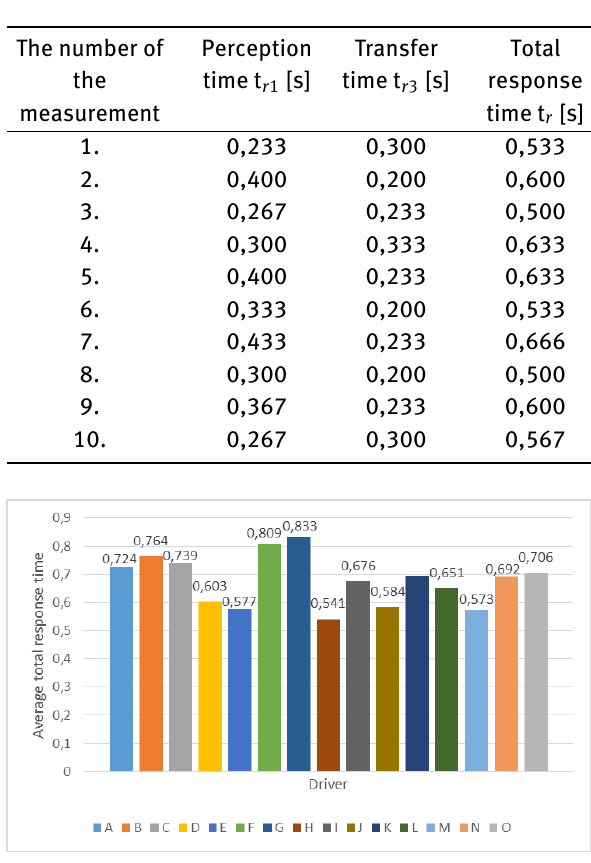
Figure 8: Summary of results of the average total reaction time.